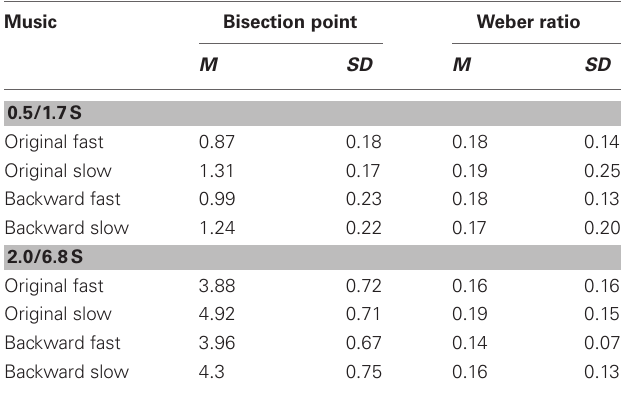
Table 2 | Means and standard deviation of the Bisection Points and Weber Ratios for musical excerpts presented in their original and backward version with a fast and a slow tempo in the 0.5/1.7 and the 2.0/6.8-s duration